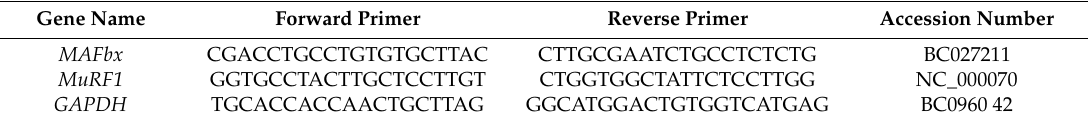
Table 1. Oligonucleotide primer sequences used for the RT-PCR